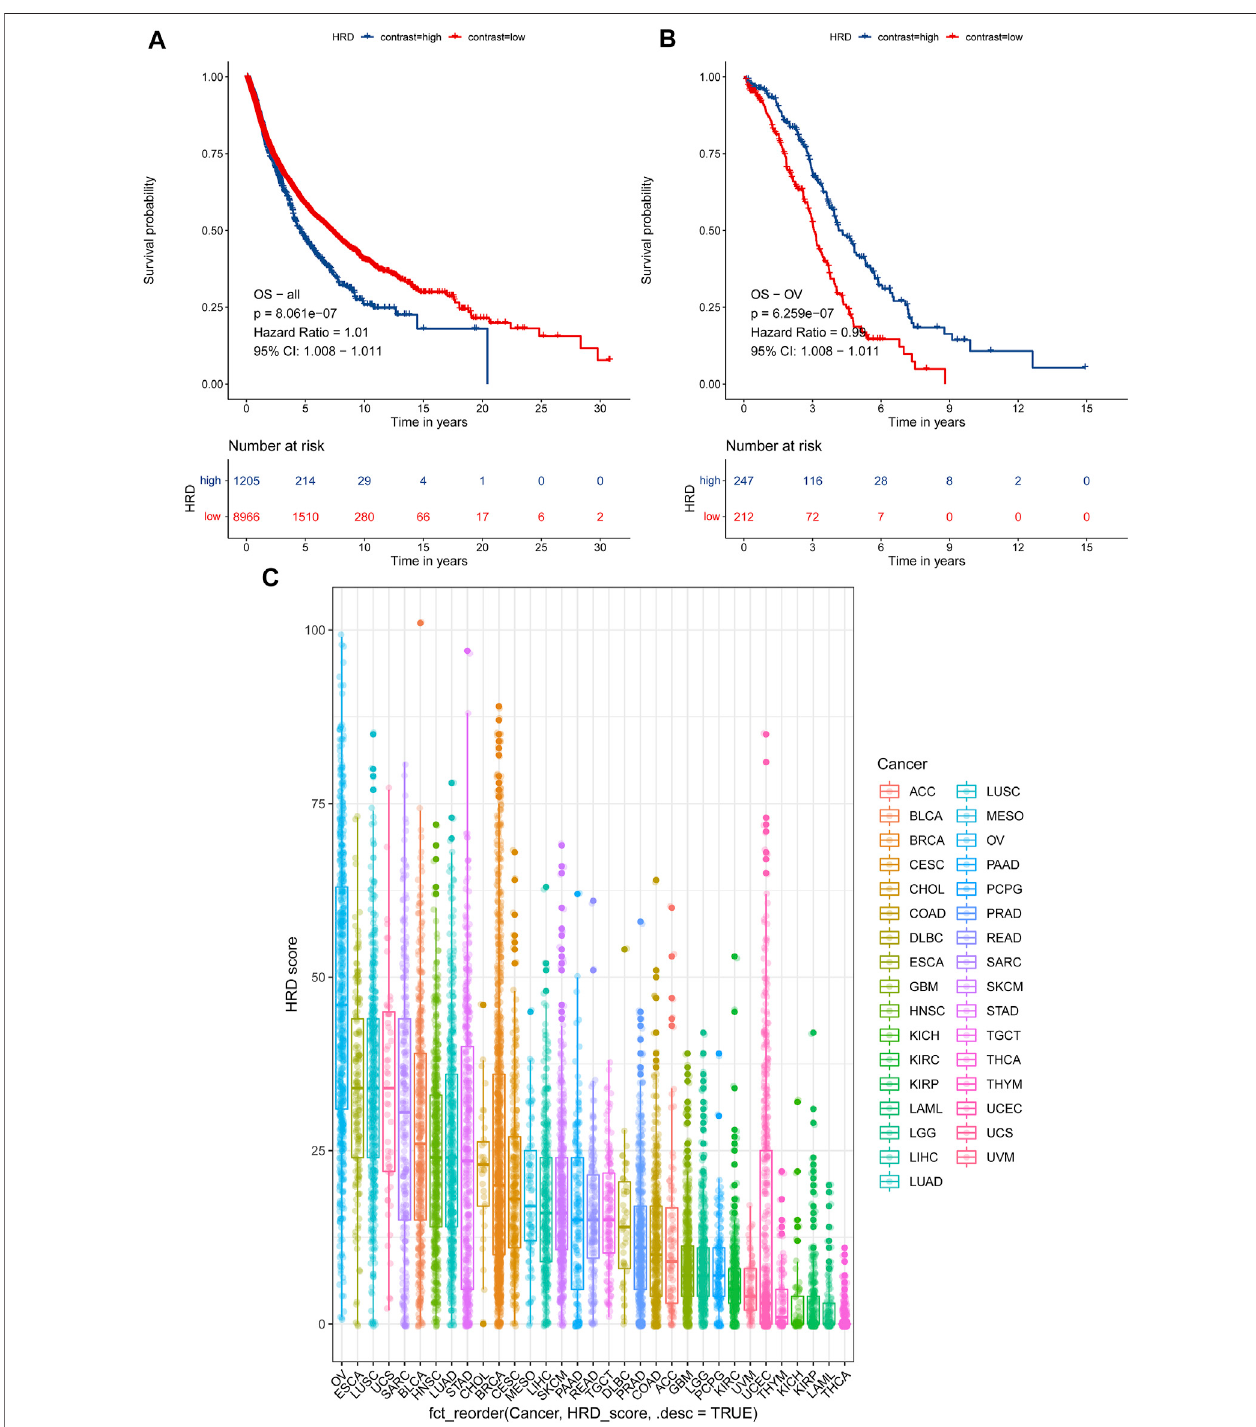
FIGURE 4 | (A) Survival analysis of OS between an HRD score ≥ 42 and an HRD score < 42 in 10,171 cases across 33 cancer types, HR (cid:1) 1.01, 95% CI (cid:1) 1.008 – 1.011, p < 0.001. (B) SurvivalanalysisofOSbetweenanHRDscore ≥ 42andanHRDscore < 42in459casesofovarian cancer,HR (cid:1) 0.99,95%CI (cid:1) 0.98 – 0.99, p < 0.001. (C) HRD combined score distribution across 33 cancer types in 10,619 cases.